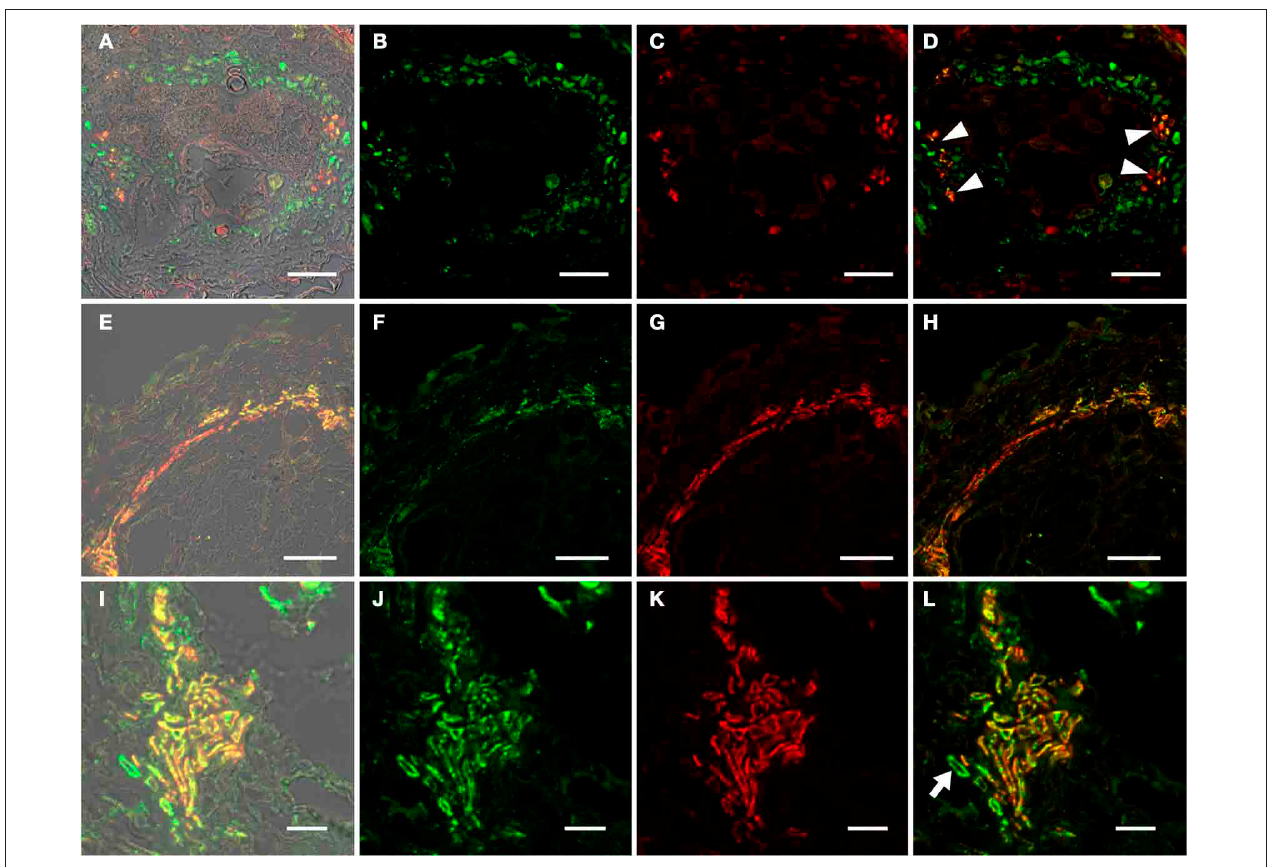
FIGURE 6 | Identification of auxin responsive cells by immunohistochemistry in sections through root-knots of P DR5 :ER - GFP Arabidopsis plants infected with M. incognita . (A–D) Section through a root knot 10dai. (E–H) Section through root knot 17dai. (I–L) detail of a section through a root knot 17dai. (B,F,J) Auxin responsive cells decorated by a GFP antibody. Green color results from a Cy2-conjugated secondary antibody. (C,G,K) Cells decorated with the